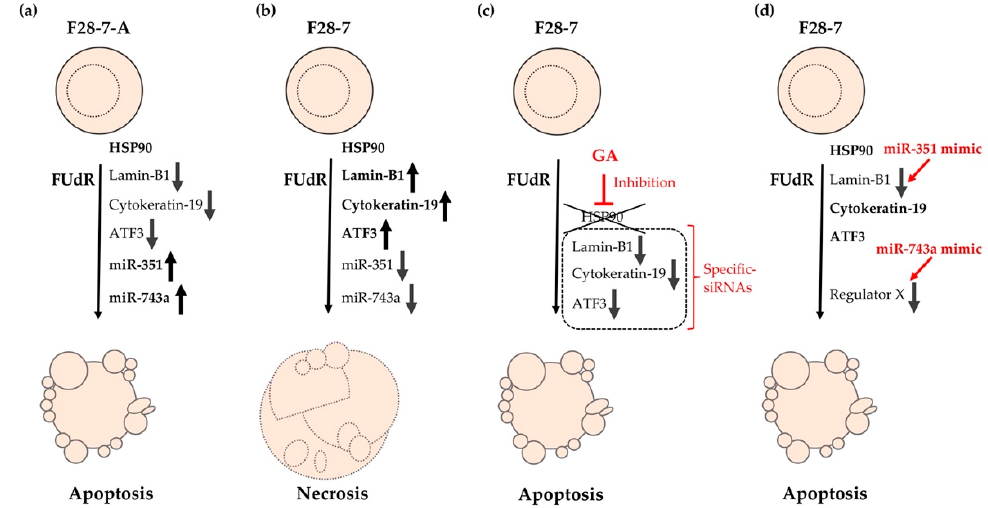
Figure 2. Cell death models of FUdR-induced necrosis and apoptosis in F28-7 and F28-7-A cells. ( a ) Treatment of F28-7-A cells with FUdR induces apoptosis. ( b ) Treatment of F28-7 cells with FUdR induces necrosis. ( c ) Co-treatment of the HSP90 inhibitor geldanamycin (GA) inhibits the expression of the switch regulators lamin-B1, cytokeratin-19, and activating transcription factor 3 (ATF3), thus resulting in apoptosis. Knockdown of switch regulators in F28-7 cells by small interfering RNAs (siRNAs) also causes a shift from FUdR-induced necrosis to apoptosis. ( d ) Increased expression of miR-351 or miR-743a in F28-7 cells by miR transfection mimics inhibits the expression of cell death regulator lamin-B1 or regulator X (unknown regulator), resulting in apoptosis. miR-351, miR-351-5p; miR-743a, and miR-743a-3p. Table 2. Identification of switch regulators, necrosis, and apoptosis.